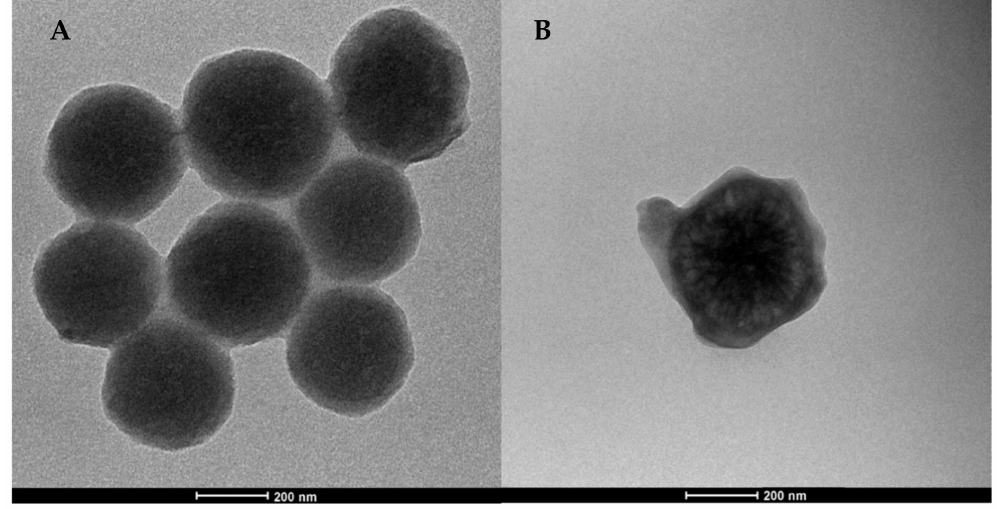
Figure 3. TEM images of PLA / SiO 2_ s ( A ) and PLA / SiO 2_ w ( B )